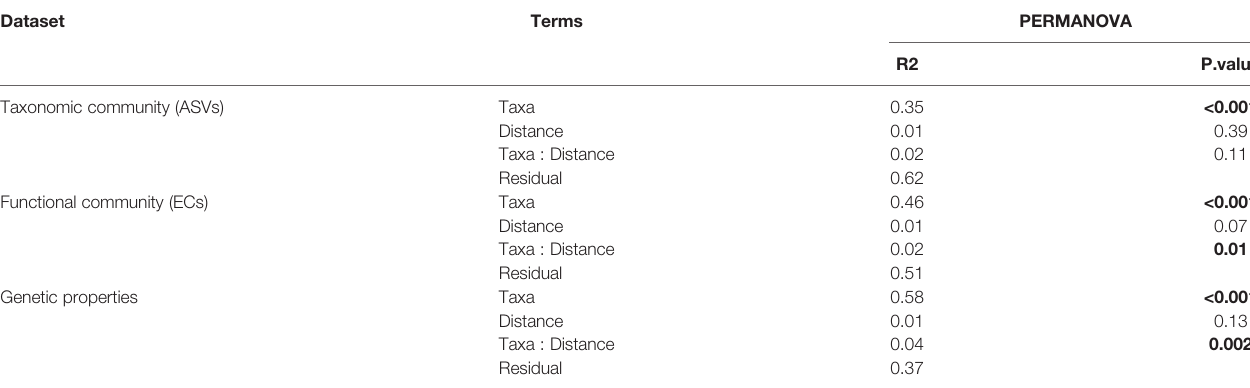
TABLE 3 | Permutational analysis of variance (PERMANOVA) per dataset and Taxa with 4th root of distance from cage as factor. Dataset